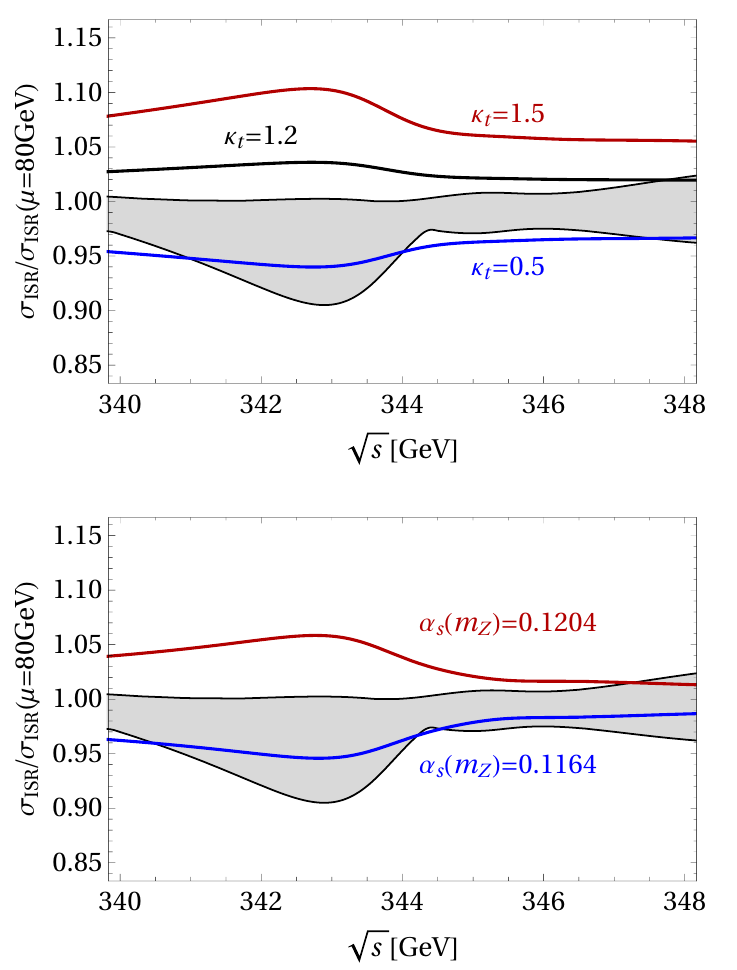
Figure 17 . The upper (lower) panel show the e(cid:11)ects of variations of the Yukawa coupling (strong coupling) on the cross section. The Yukawa coupling is parametrized as y t = (cid:20) t y SM p 2 m t =v is the Standard Model value. The predictions are normalized to the full cross section and the uncertainty band is the same as in (cid:12)gure